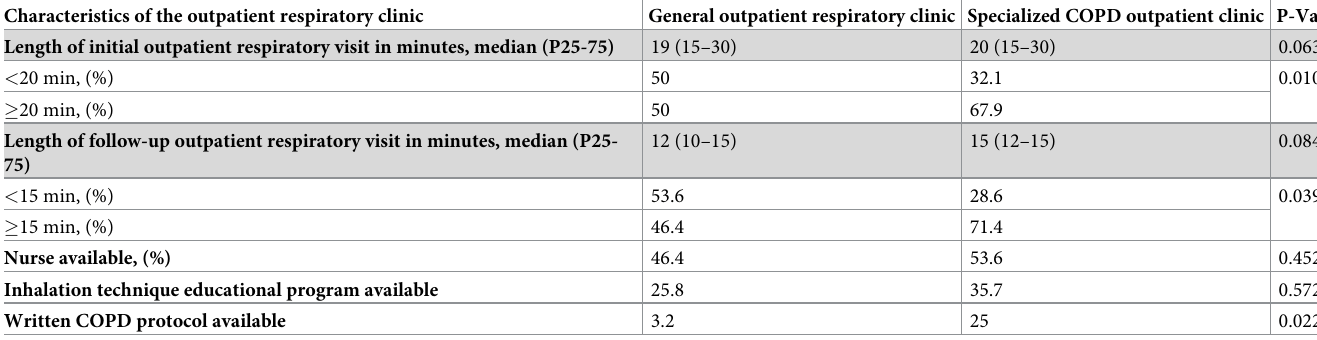
Table 1. Resources in general and specialized COPD outpatient respiratory